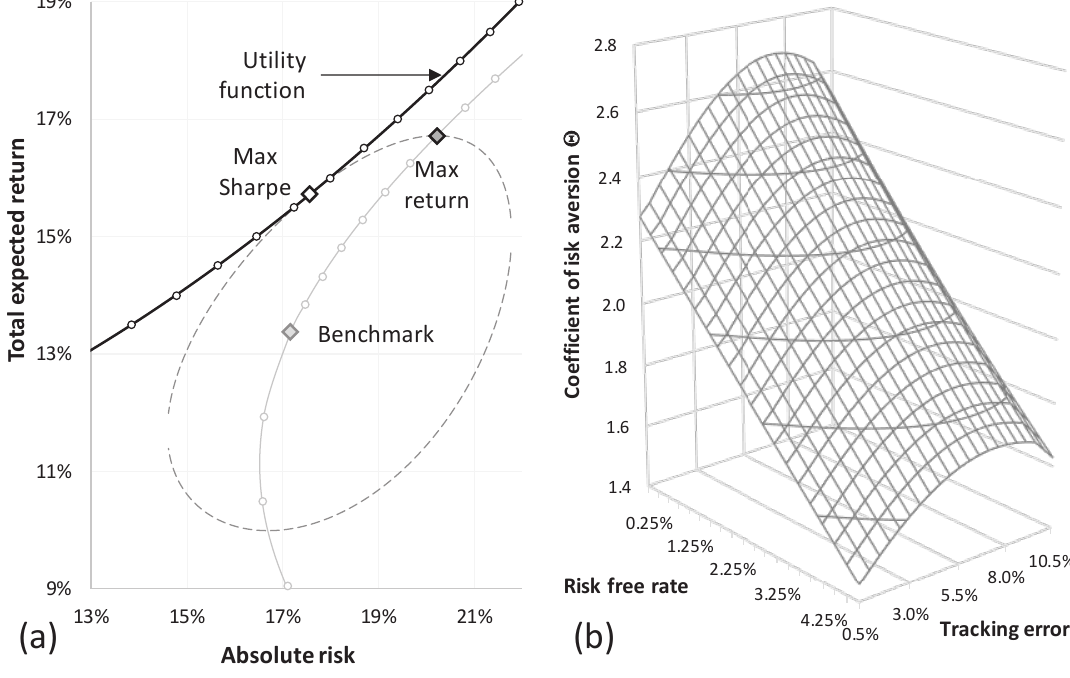
Figure 5. (a) Utility function tangential to the maximum Sharpe ratio portfolio on the constant TE frontier and (b) θ as a function of tracking error and risk-free